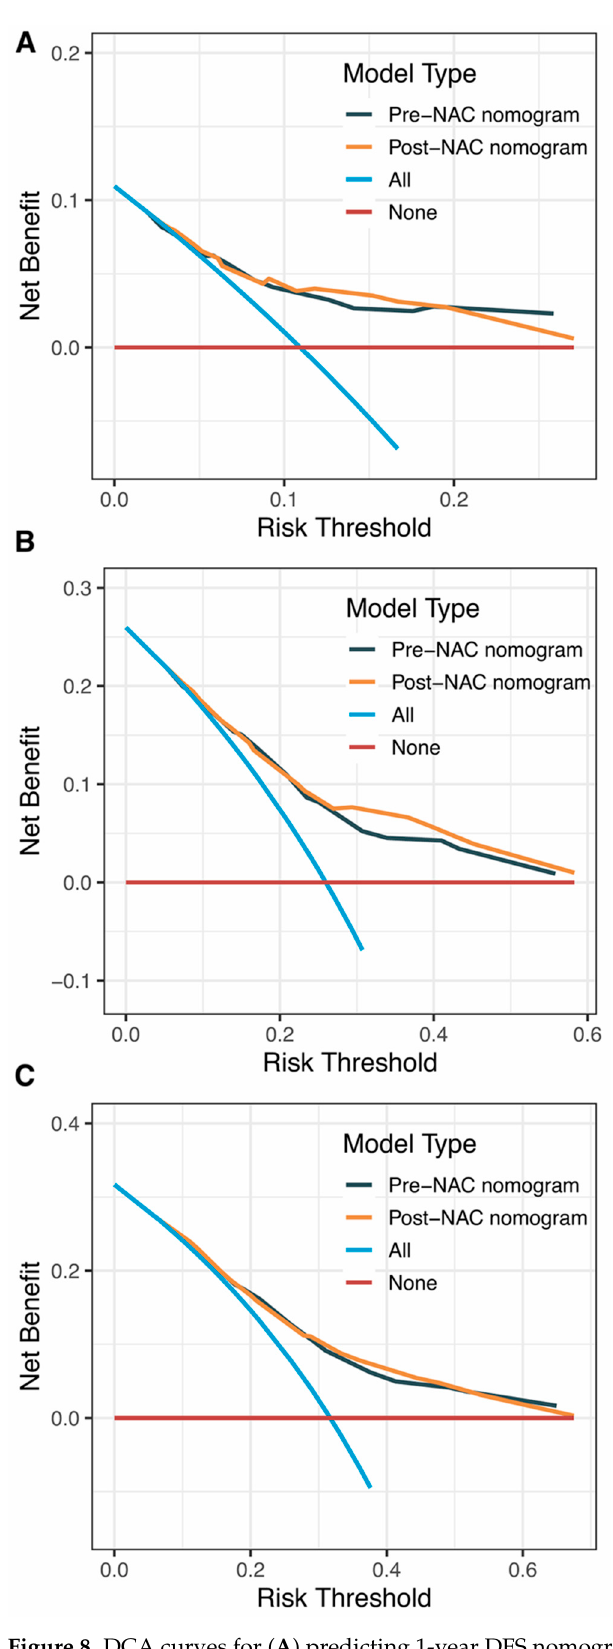
Figure 8. DCA curves for ( A ) predicting 1-year DFS nomograms; ( B ) predicting 3-year DFS nomo- grams; ( C ) predicting 5-year DFS nomograms. Abbreviations: DCA, decision curve analysis; DFS, disease-free survival; NAC, neoadjuvant chemotherapy.